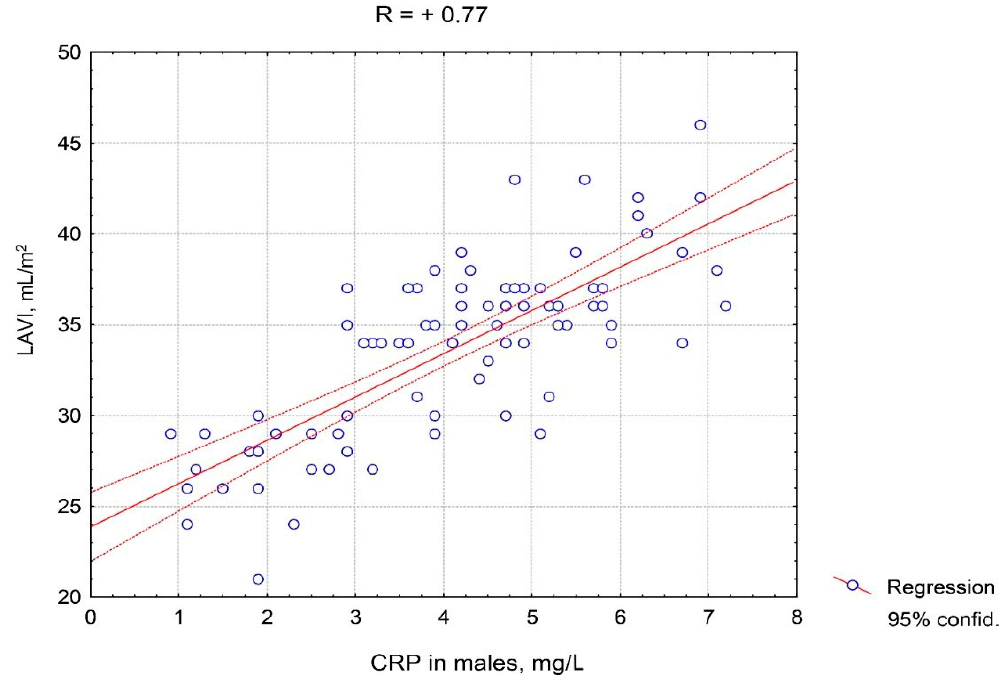
Figure 4. Correlative association of the C-reactive protein serum level and the left atrium volume index in males with hypertension complicated by CHF with preserved left ventricle ejection fraction.